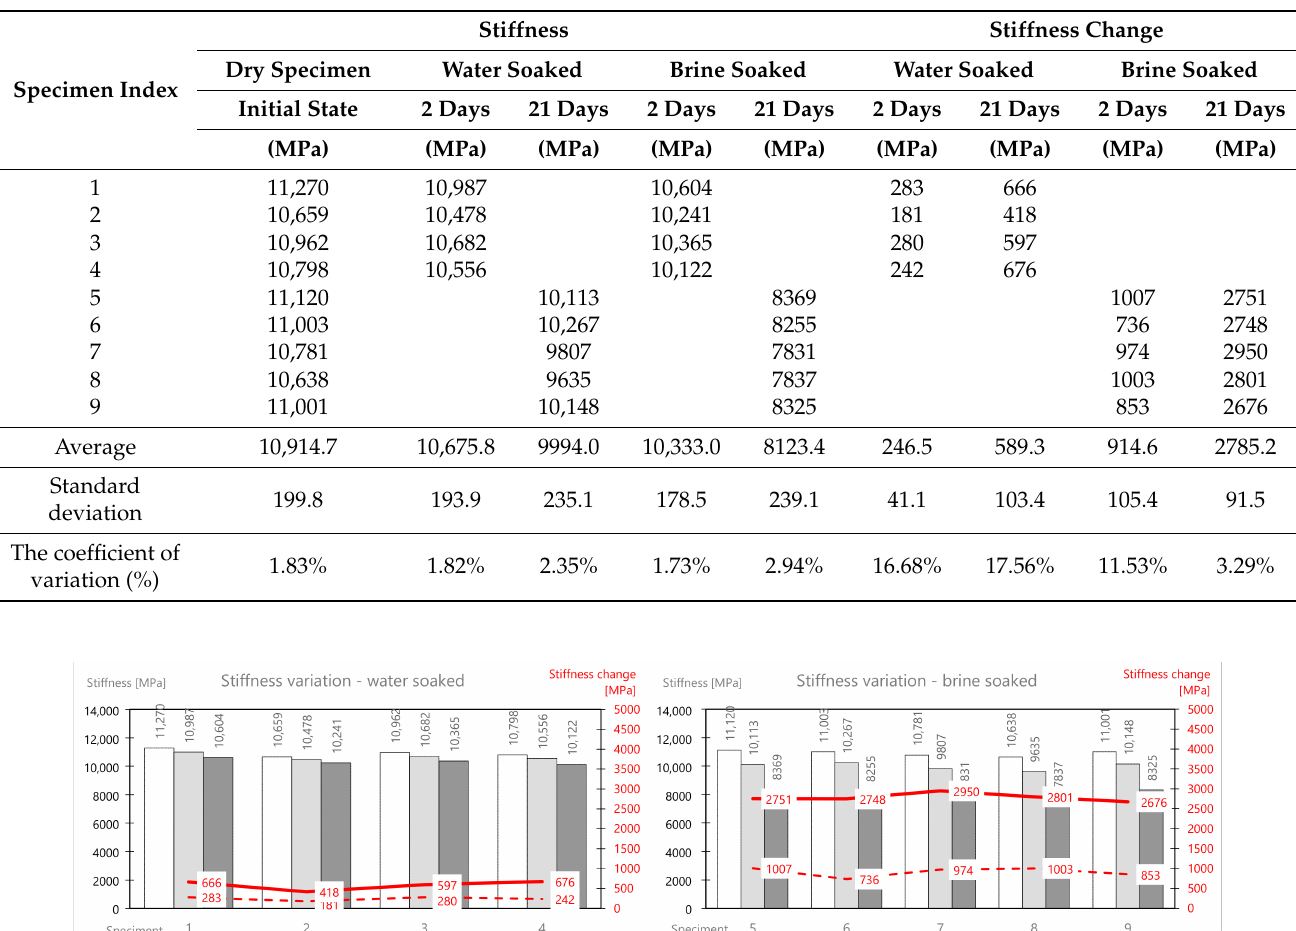
Table 4. AC11S mix stiffness variation via water and brine soaking.